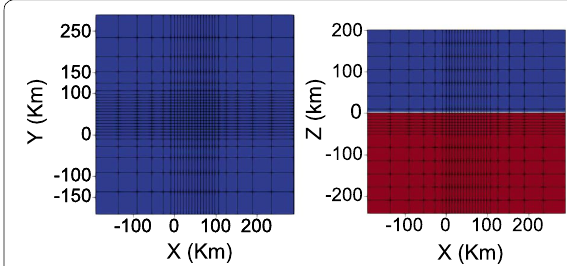
Fig. 13 Anisotropic homogeneous model. Computational grid, showing the discretization of the homogeneous anisotropic Earth model. Blue color corresponds to the air domain, and the red color corresponds to the anisotropic subsurface with the diagonal conductivity tensor defined in Eq. (32).The input model was extended 50 km downwards in z ‑direction, increasing the depth to 100 km before the extension zone. The air height is 10 km. A spacing of d x = d y = d z = 7 km has been chosen. The extension zone has a width of 191 km for all directions. The computational grid has dimensions of x , y ∈ [− 241.1,239.1 ] km, and z ∈ [ 0,442.2 ] km